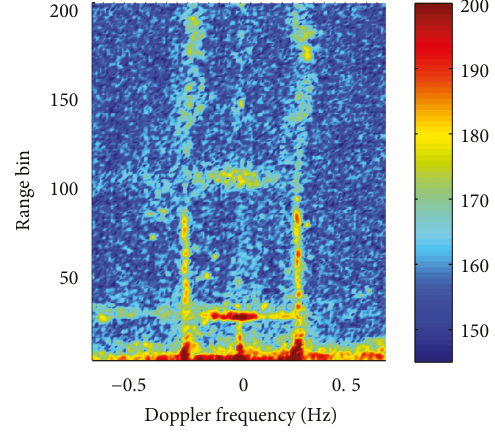
Figure 16: Range-Doppler maps by the DBF method.